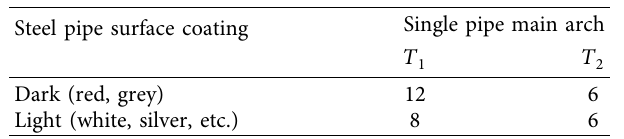
Table 2: Temperature differences T 1 and T 2 specified in the Chinese code ( °